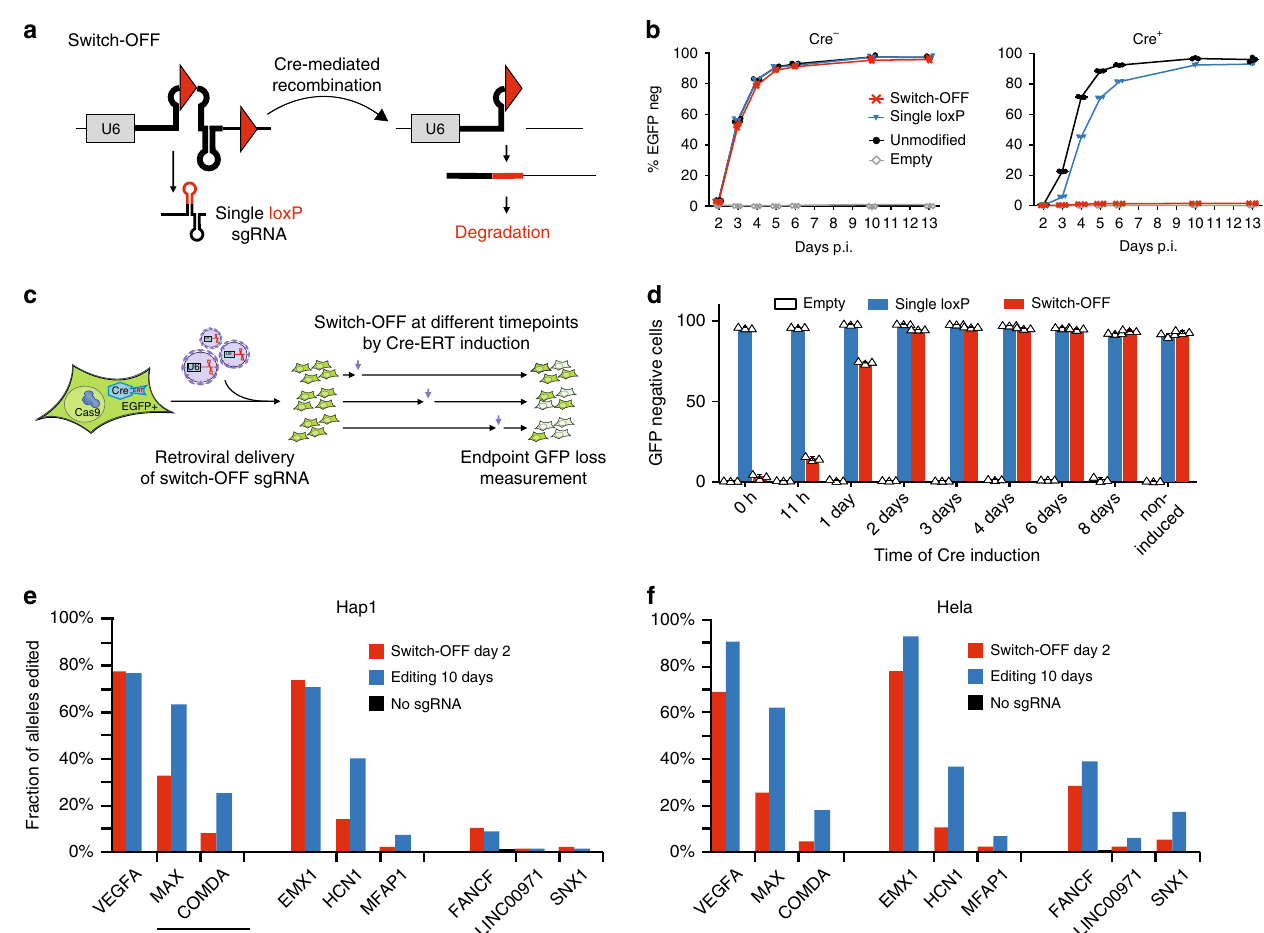
Fig. 2 Inducible Switch-OFF of sgRNA expression. a Locus architecture of sgRNA Switch-OFF system in “ on ” (left) and “ off ” (right) states. sgRNA and sgRNA-coding sequence is shown as thick line stem-loop structure and recombination sites are represented as triangles. Single loxP-derived stem-loop within sgRNA scaffold produced in the “ on ” state is shown in red. U6 – U6 promoter. b EGFP loss kinetics (see Fig. 1b, c) obtained by Switch-OFF sgRNA in absence (left) and presence (right) of Cre. sgRNA constructs with optimized scaffold and no targeting sequence or with sgEGFP1 were used as negative and positive controls, respectively. Error bars represent standard deviation ( n = 3). c Experimental setup. Cassettes encoding sgEGFP1 are delivered on retroviruses into EGFP and Cas9 encoding cells. Switch-OFF is induced at different time-points post infection and the level of EGFP loss is measured for all the induction time-points 14 days p. i. d EGFP loss obtained after gEGFP1 Switch-OFF at different time-points post infection in red. Constitutively expressed single loxP sgEGFP1 was used as a positive control. Error bars represent standard deviation ( n = 3). Cas9 + Hap1 cells ( e ) and Hela cells ( f ) targeted with sgRNAs show high editing rates on target (bold, VEGFA, EMX1, FANCF), but also for respective off-target sites (MAX, COMDA; HCN1, MFAP1; LINC00971, SNX1;), when editing continuous for ten days (blue), while termination of editing by Cre transduction two days subsequent to sgRNA transduction (red) halts editing. Termination of editing results in a better on-/off-target ratio due to near-saturation of on-target editing already at day 2. Source data are provided as a Source Data fi